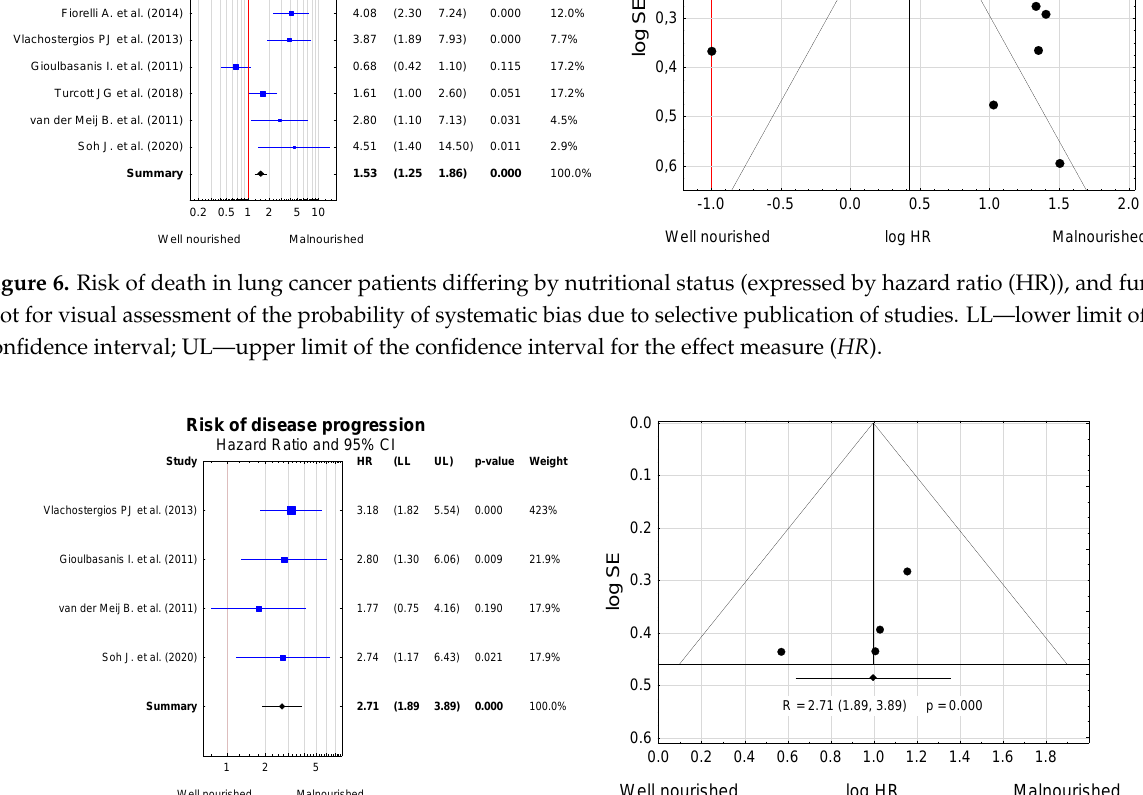
Figure 6. Risk of death in lung cancer patients differing by nutritional status (expressed by hazard ratio (HR)), and funnel plot for visual assessment of the probability of systematic bias due to selective publication of studies. LL — lower limit of the confidence interval; UL — upper limit of the confidence interval for the effect measure ( HR ).